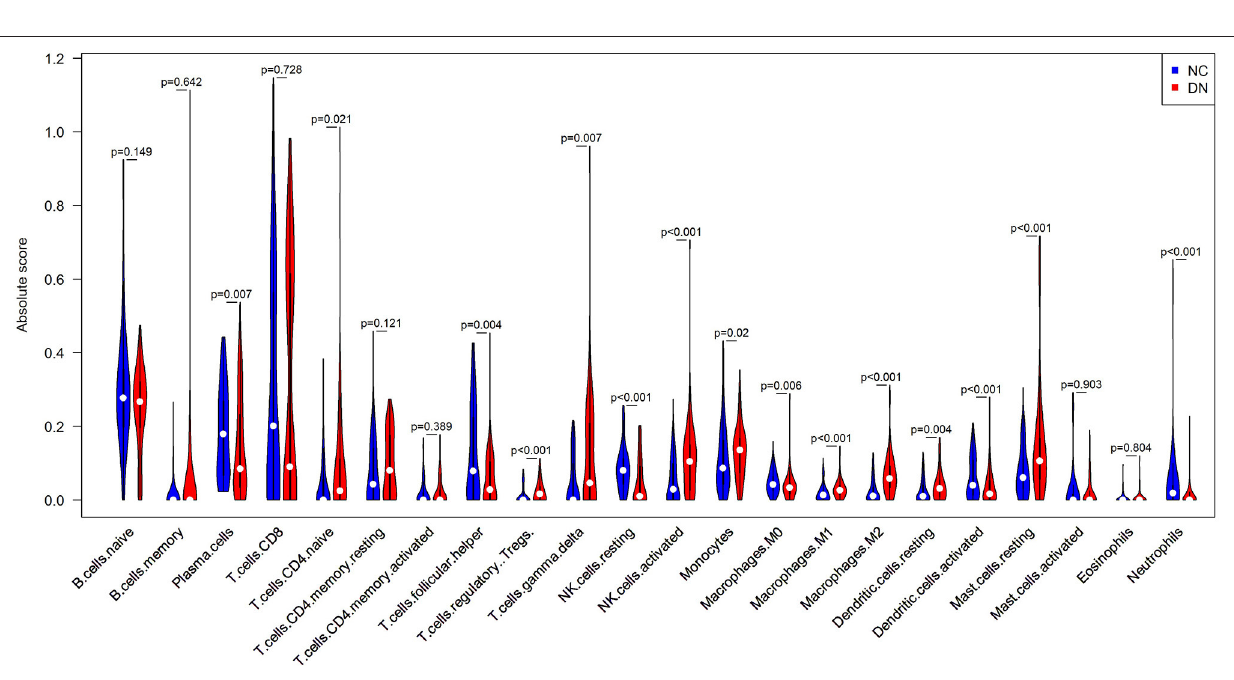
collagen is accumulated in the glomerulus (94, 95).